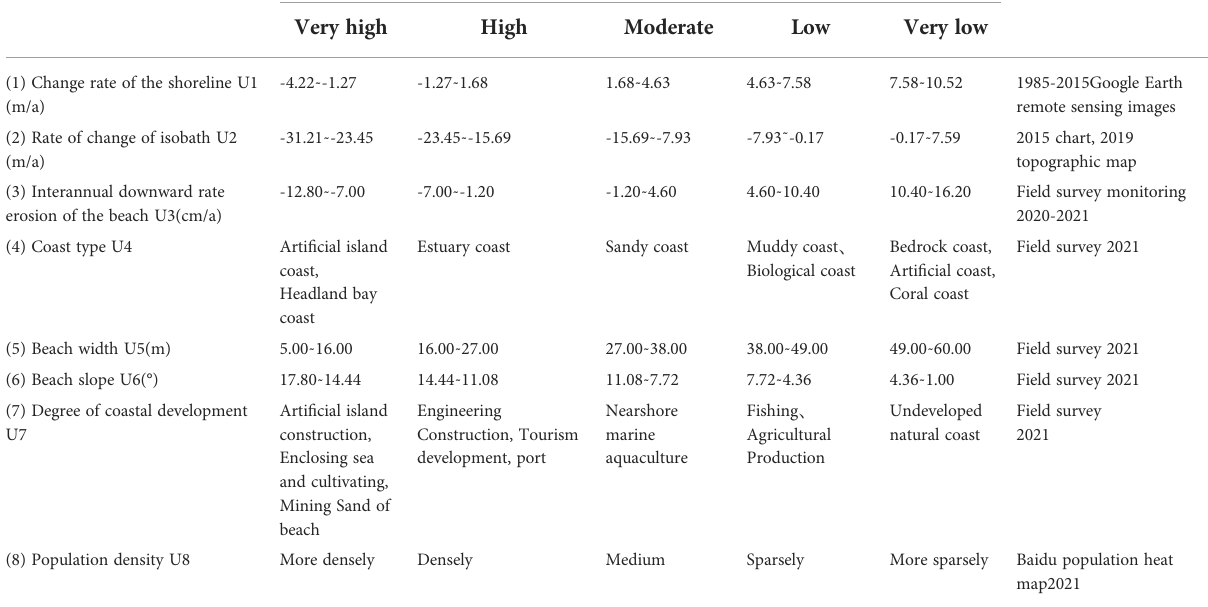
TABLE 1 Assessment indicator vulnerability grading scale.